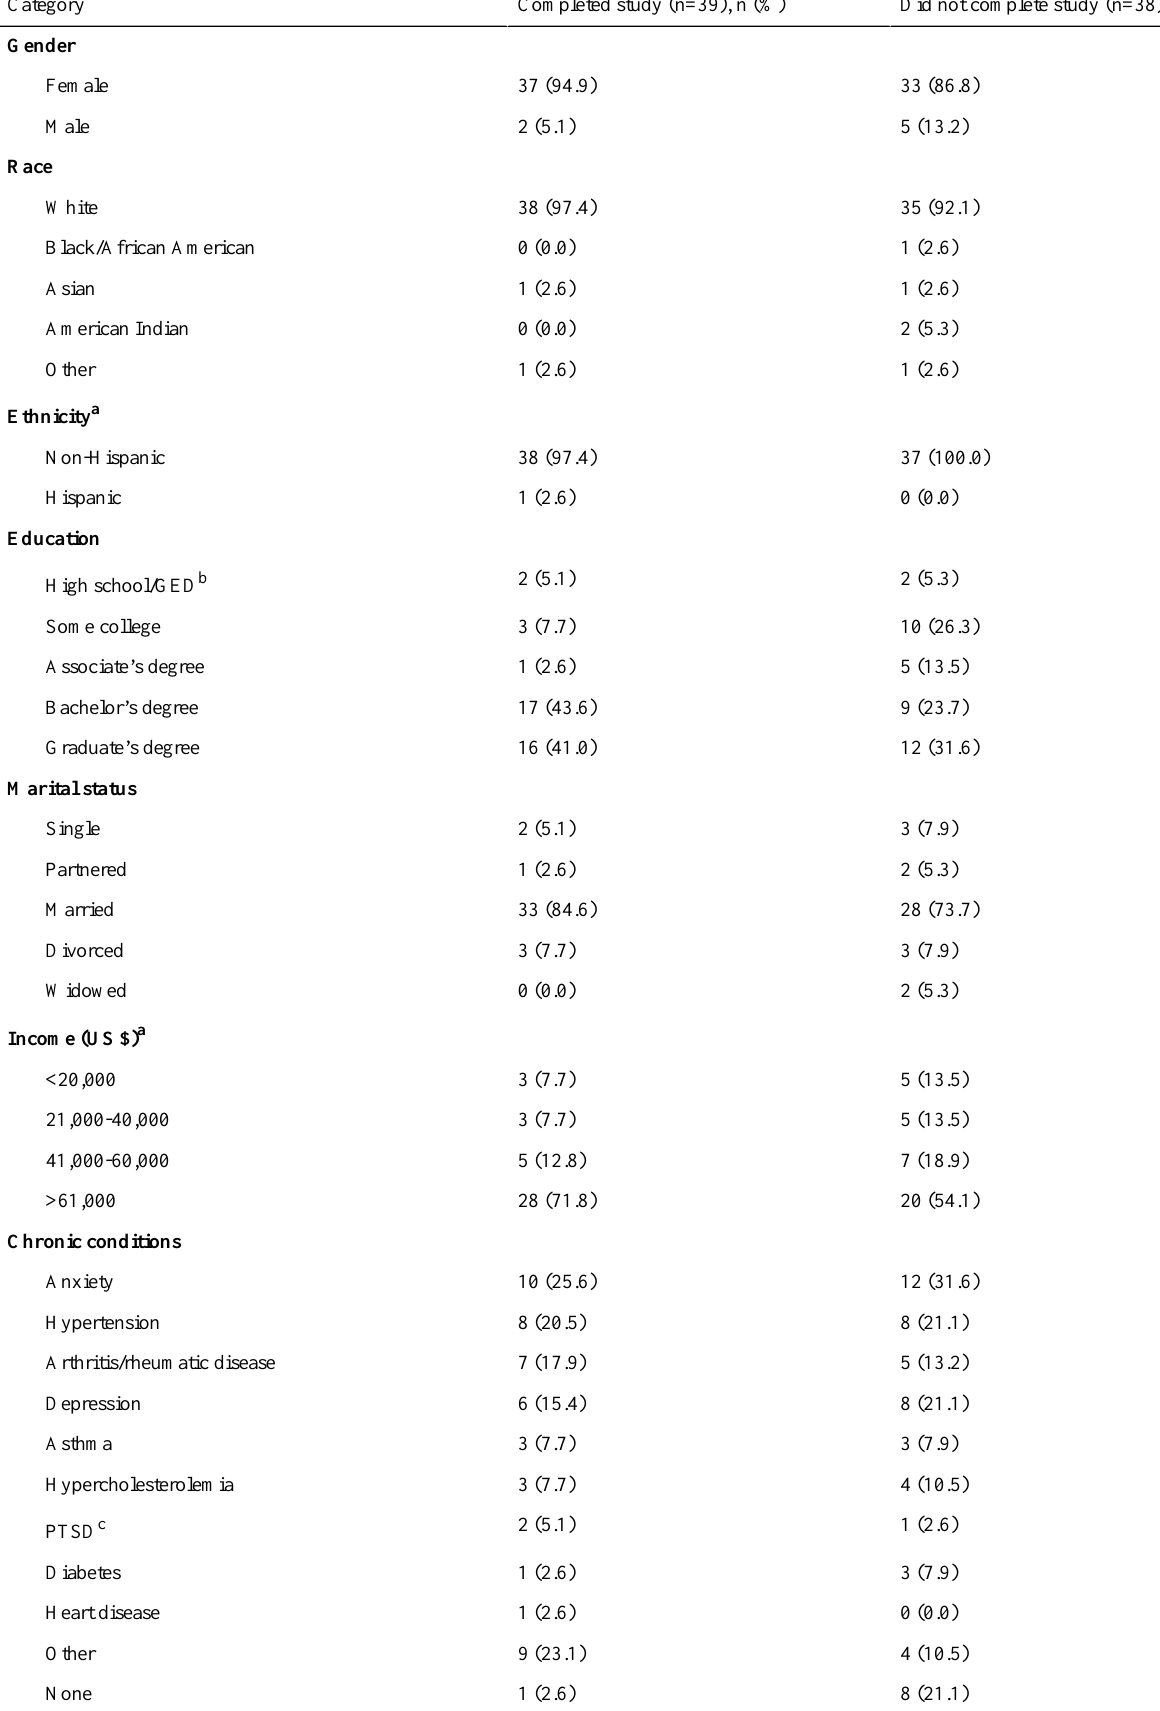
Table 1. Demographic characteristics of the